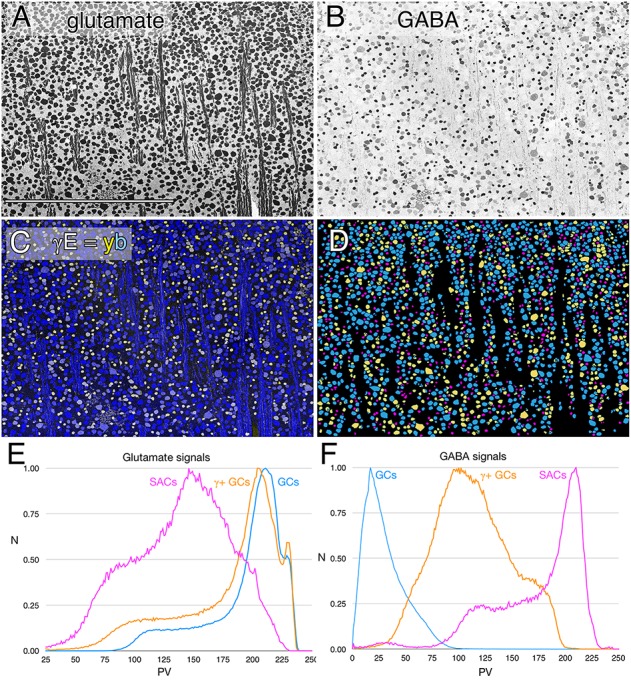
Glutamate and GABA colocalization in the rabbit ganglion cell layer; registered serial 200 nm horizontal sections through the plane of the ganglion cell layer with silver density visualization. (A) Raw glutamate signals of ≈2100 cells, density mapped; Scale, 0.5 mm. (B) Raw GABA signals of the same cells, density mapped. (C) Intensity mapped [inverse images of A,B)] registered channels with GABA (γ) signals encoded as a yellow (y) channel (R + G) and glutamate signals (E) as the blue (b) channel (γE = yb mapping) to create additive and quantitative concentration maps that reflect the free amine content of the cells. (D) Theme mapped data produced through GABA histogram segmentation. Magenta: high GABA content (5–10 mM) population containing mostly starburst amacrine cells and a few displaced amacrine cells. Yellow: medium GABA content population containing provisional γ+ ganlion cells (0.1–1 mM). Cyan: Ganglion cells with no measurable GABA content (<0.1 mM); small fragments represent portions of cross-sectioned cell dendrites. (E) Glutamate histograms of peak normalized pixel number (N) vs. pixel value (PV) for starburst amacrine cells (SACs), GABA-positive ganglion cells (γ+ GCs) and GABA-negative ganglion cells (GCs). The pixel value is the digital grayscale readout from the raw imagery, ranging from 0 to 255 and the peak normalized pixel number is the normalized maximum frequency of pixels in the image for a given pixel value. Pixel value reflects the quantitative amounts of small molecules which are log-linearly scaled with histogram pixel value representing an approximation of concentration (Marc et al., 1995). (F) GABA histograms of peak normalized pixel number (N) vs. PV for starburst amacrine cells (SACs), GABA-positive ganglion cells (γ+ GCs) and GABA-negative ganglion cells (GCs).